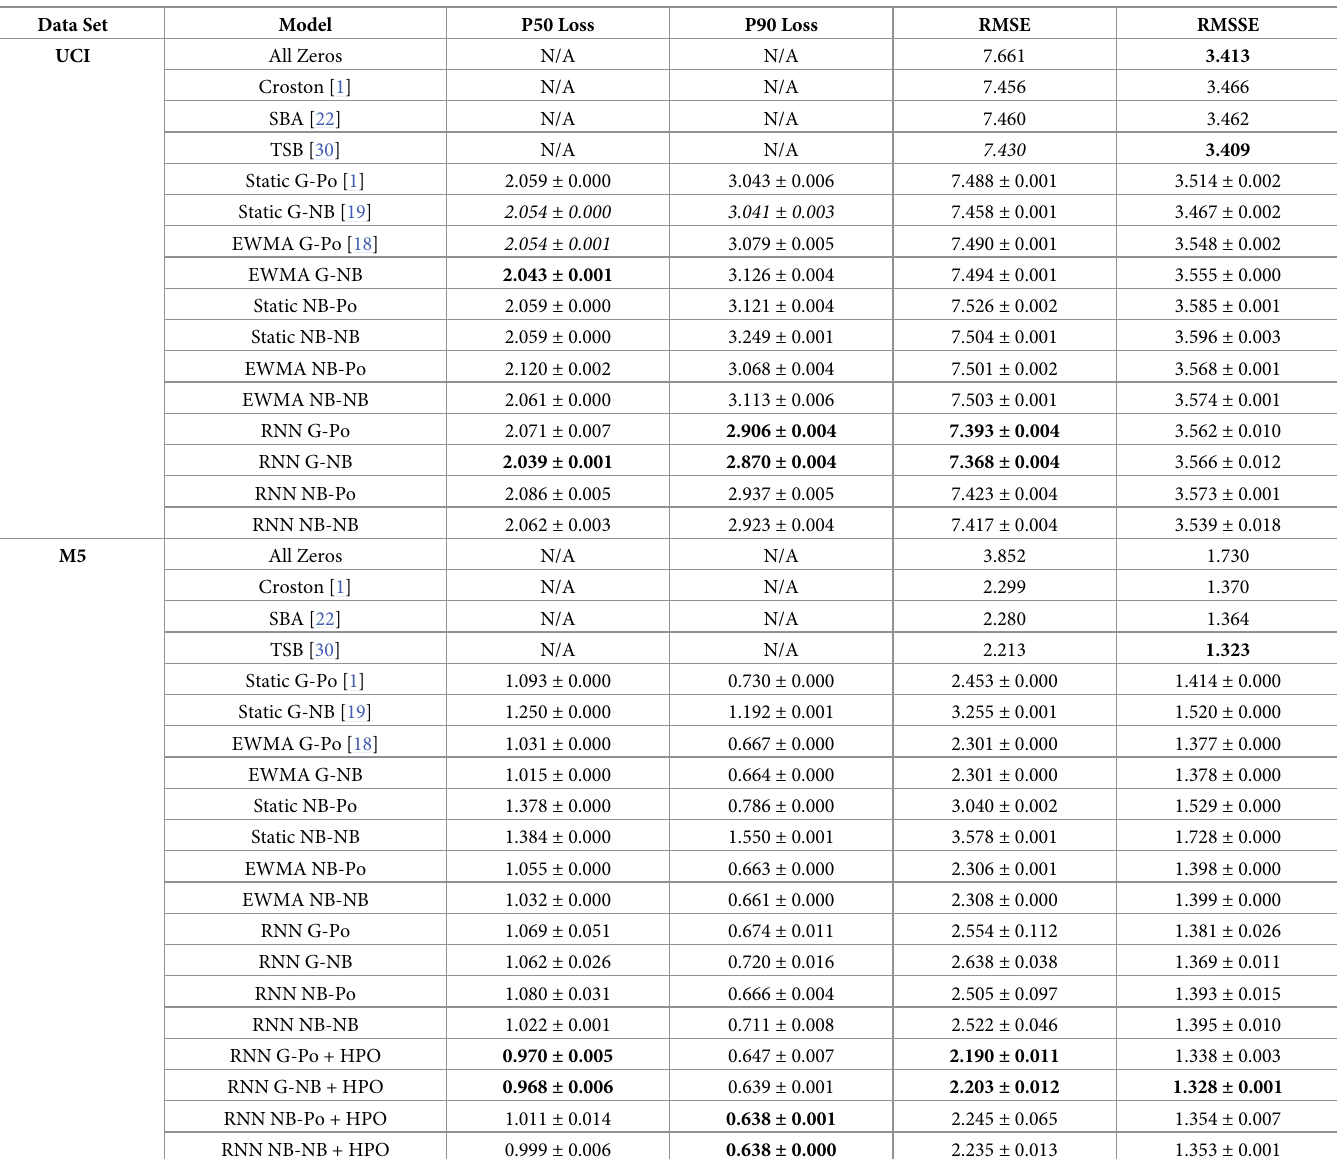
Table 7. Experiment results for discrete-time models with UCI and M5 sets. Data